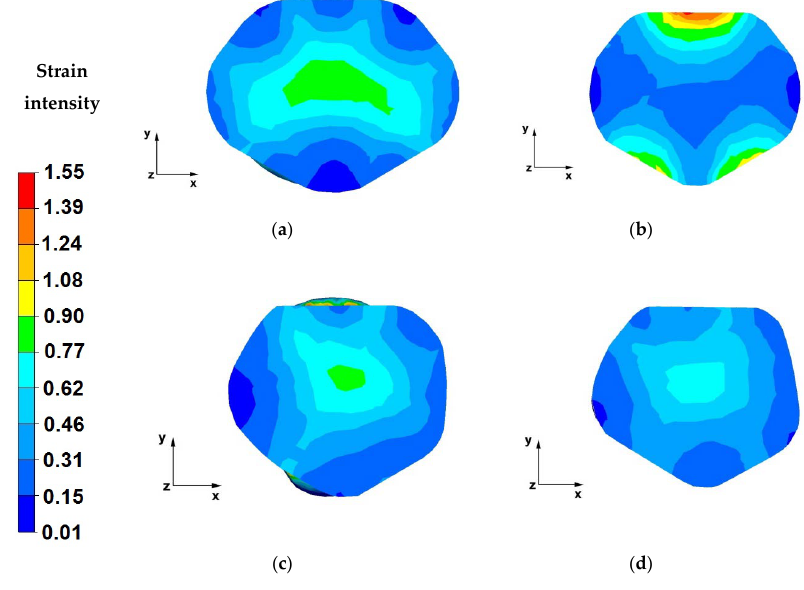
Figure 16. ( a ) Distribution of strain intensities over the cross-section of an AZ91 alloy forged within the first pass, with a relative reduction of 25%, in trapezoid-rhombic dies; ( b ) Distribution of strain intensities over the cross-section of an AZ91 alloy forged within the second pass, with a relative reduction of 25%, in trapezoid-rhombic dies; ( c ) Distribution of strain intensities over the cross-section of an AZ91 alloy forged within the third pass, with a relative reduction of 40%, in trapezoid-rhombic dies, after a 90° turning of the forging; ( d ) Distribution of strain intensities over the cross-section of an AZ91 alloy forged within the fourth pass, with a relative reduction of 40%, in trapezoid-rhombic dies, after a 90° turning of the forging. The data in Figure 16a indicates that the strain intensity values were the highest in the axial zone of the forging, along axis-Z, and fell within a range of 0.29–0.35. The strain intensity distribution within the analysed area was uniform. The strain intensity values in the areas of direct die action on the alloys were also uniform and fell within a range of 0.17–0.23. Based on the analysis of the entire forging cross-section, it is possible to conclude that the intensity distribution is more uniform relative to the distribution for forging in flat dies (Figure 15a).